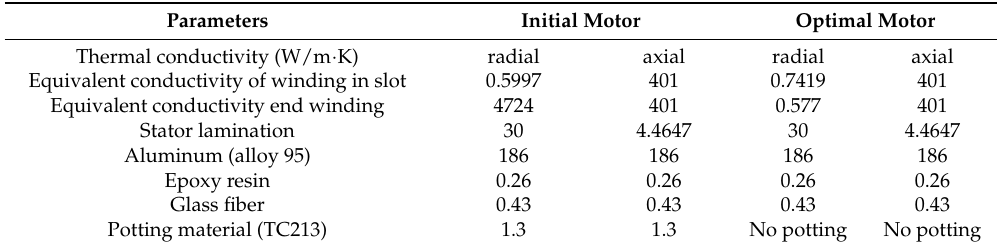
Table 14. Parameters used in the steady stator thermal